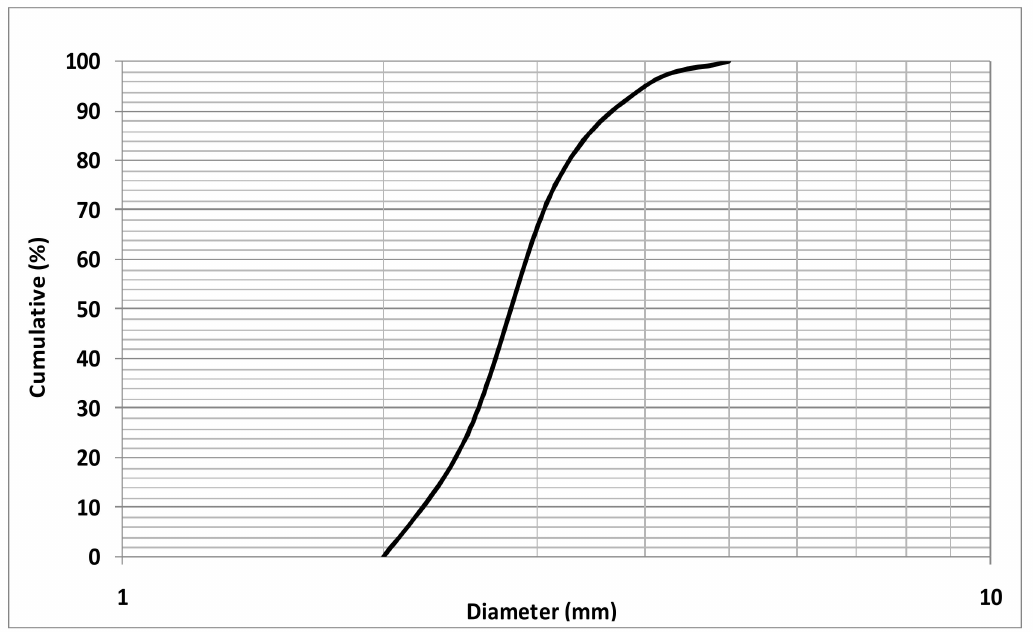
Figure 2. Particle size distribution curve of Expanded Perlite Aggregates (EPA).